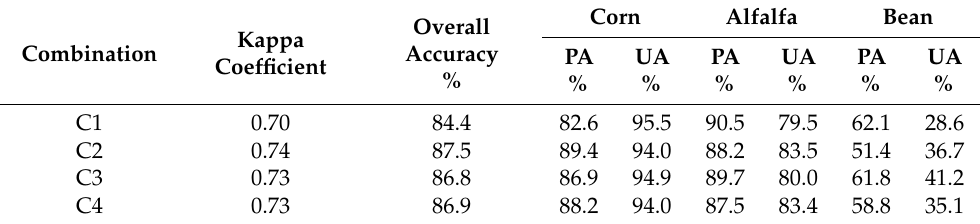
Table 13. Results of the classification on 20 June in the 2020 agricultural